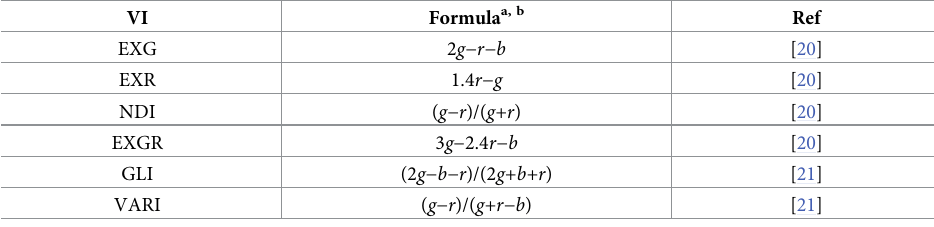
Table 4. Formulas of vegetation